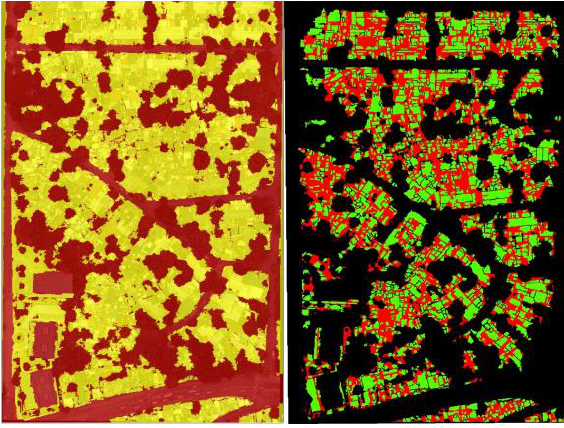
Figure 5. Non-ISS Removal output (left) and delineated ISS features (right) of the site.